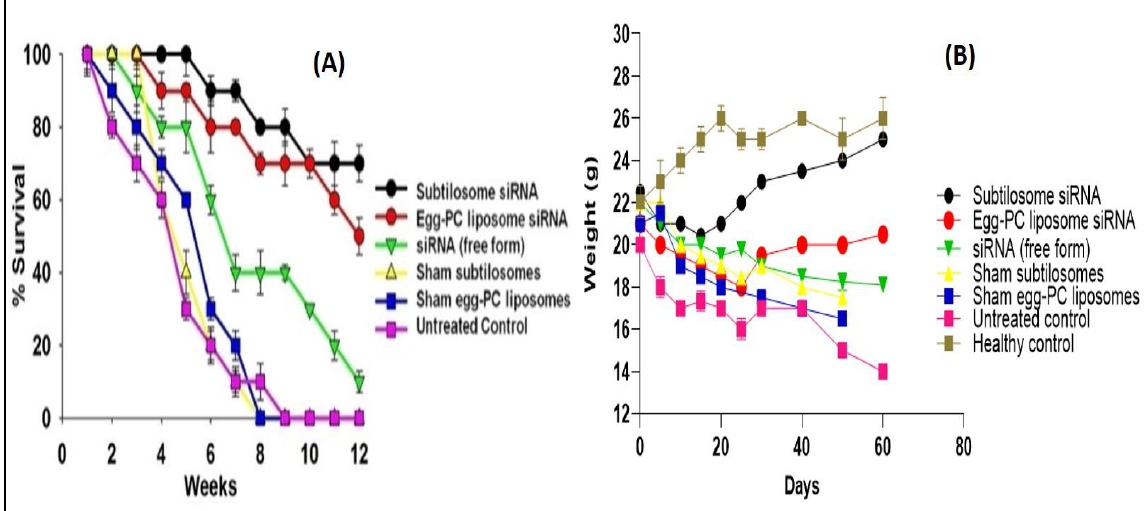
Figure 8. ( A ) Survival graph of the animals belonging to various experimental groups treated with different COX-2-siRNA-encapsulated liposomal formulations. Survival was monitored twice a day for 12 weeks. Each group had 10 animals. Data represented here are the means of three different experiments ± SD (subtilosome siRNA versus free siRNA p < 0.005, PC-liposome siRNA versus free siRNA p < 0.05, subtilosome siRNA versus PC-liposome siRNA p value not significant). ( B ) Animal-weight total. The analysis was conducted every week.